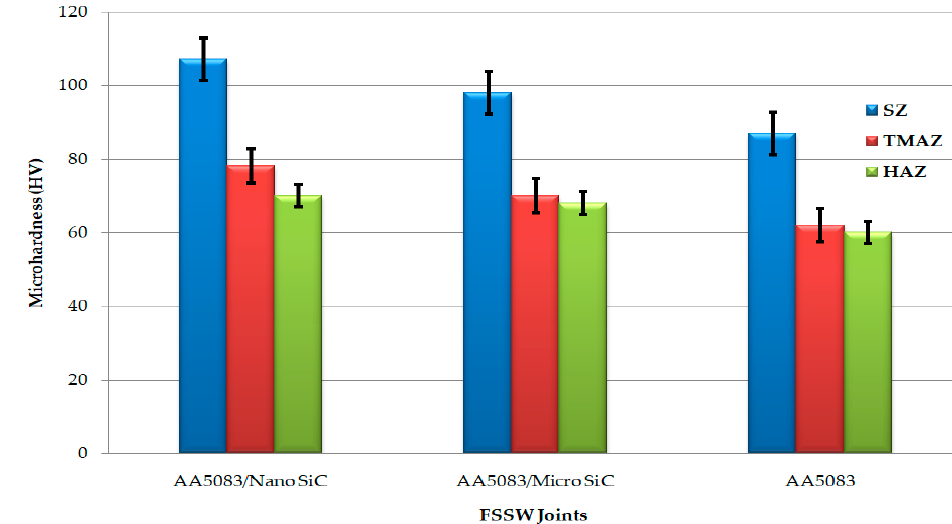
Figure 10. Microhardness measured transversely along different zones (SZs, TMAZs, and HAZs) for the FSSW SiC-particle-reinforced AA5083 samples and the without-reinforcement AA5083 samples.